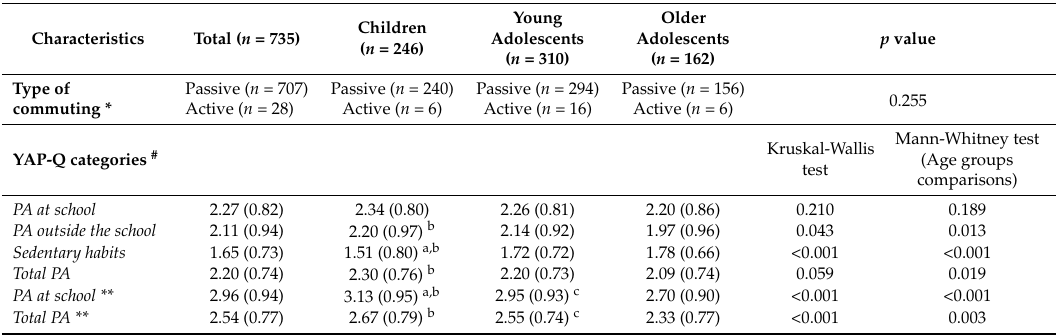
Table 2. Type of commuting to and from school and youth activity